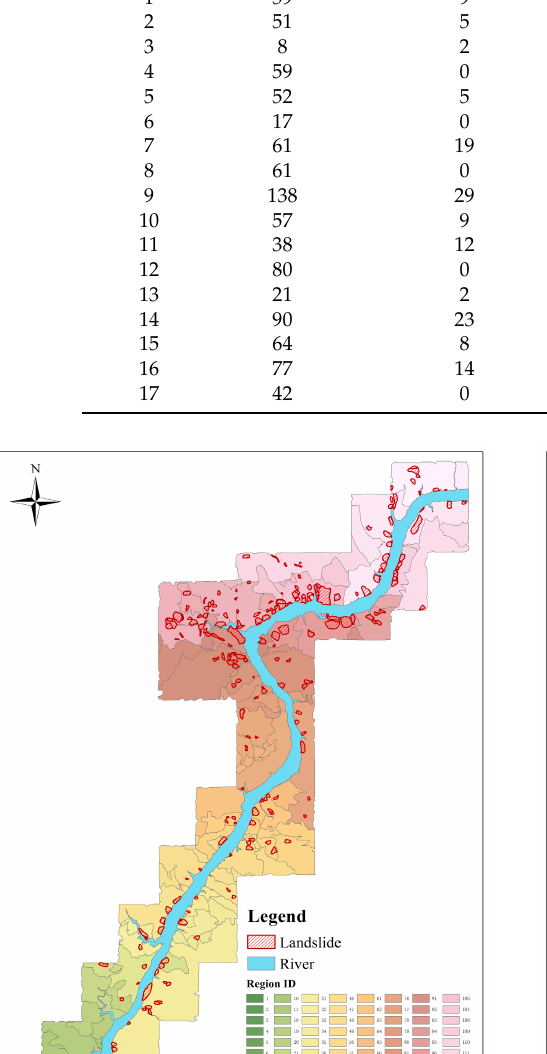
Number of Region Number of Landslide ID Slope-Units Slope-Units